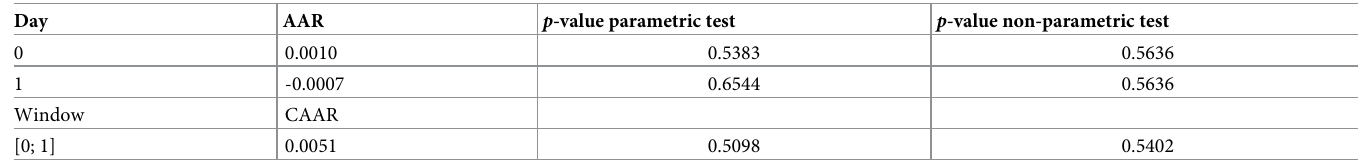
Table 2. Estimation results and test statistics of (cumulative) AARs in relation to president Trump’s tweets with companies named. Day AAR p -value parametric test p -value non-parametric